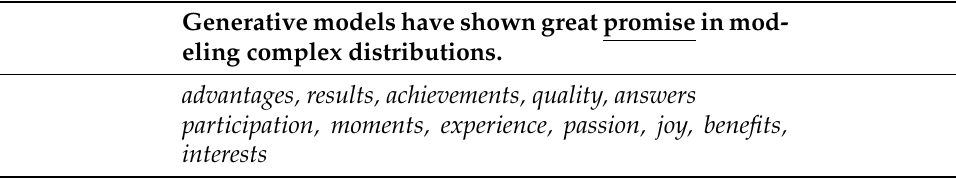
Table 2. Variational sampling. Example sentence in ( bold ) that was used as the input to the VAT, with only the underlined token being sampled. Samples from the latent distribution in italics